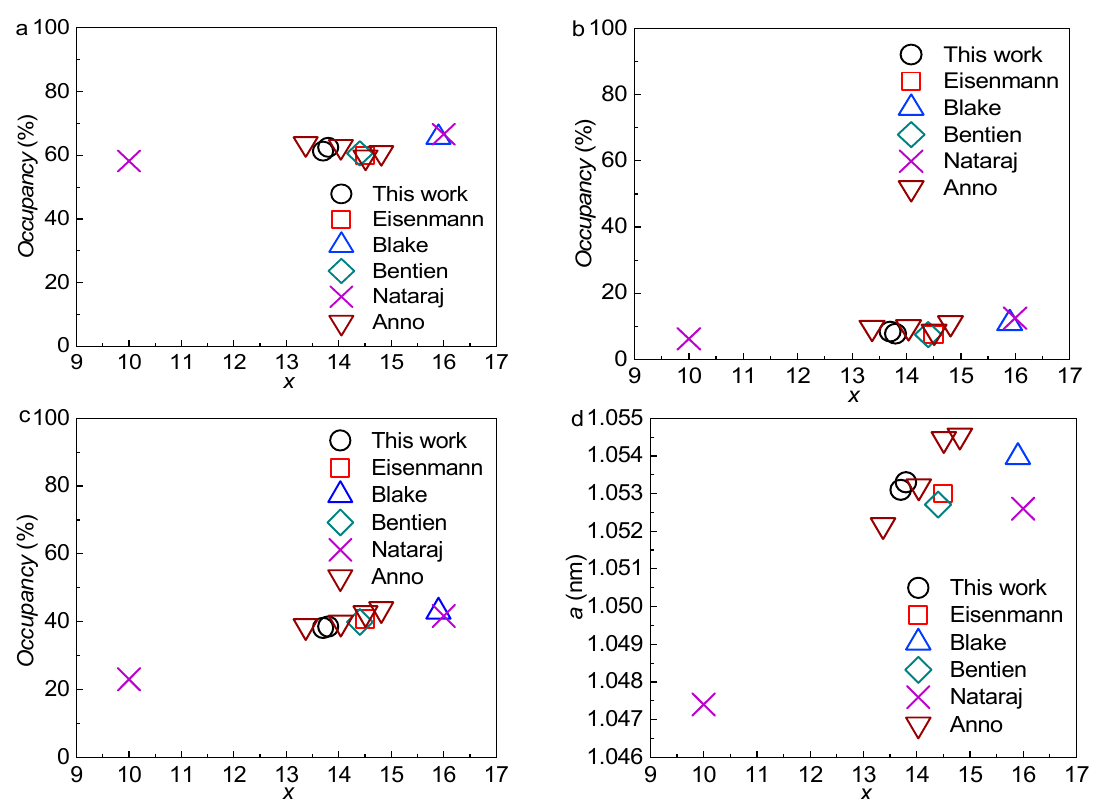
Figure 6. Occupations of Ga at different sites vs the Ga content x in the type I clathrates Ba 8 Ga x Si 46 − x : ( a ) at the 6 c site; ( b ) at the 16 i site; and ( c ) at the 24 k site. ( d ) Lattice parameter vs. x. The data from the present work are denoted by black circles.